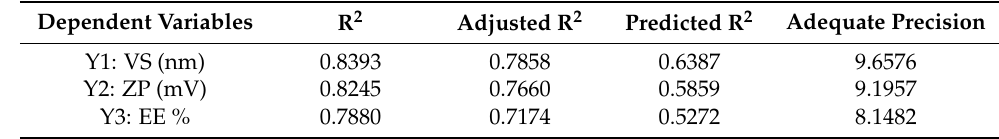
Figure 2. Contour plot for the effect of Glycerol concentration and Cholesterol concentration on Vesicles size ( A ), Zeta potential ( B ), Entrapment efficiency% ( C ), and Desirability ( D ).